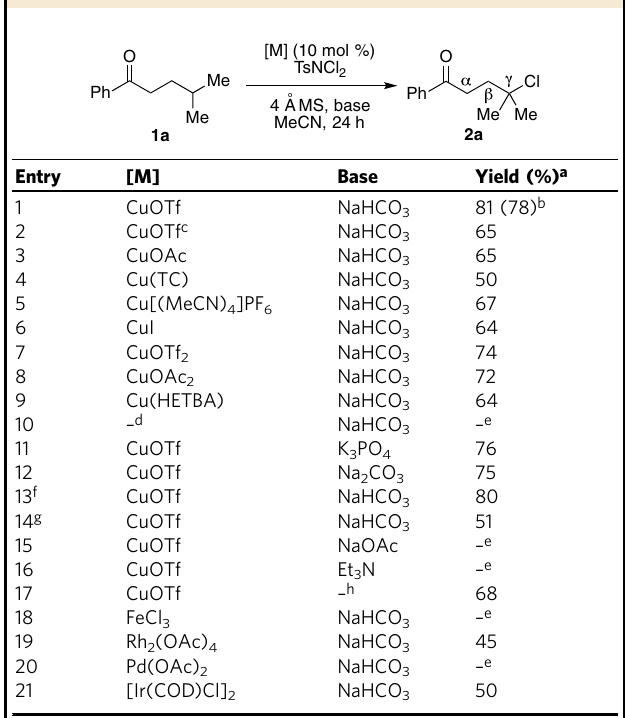
Table 1 Optimisation of the reaction